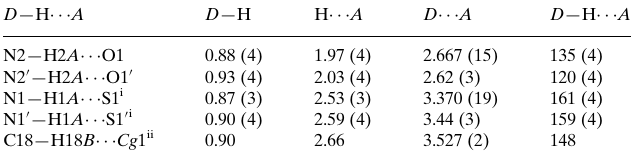
Hydrogen-bond geometry (A ˚ , (cid:2) ). Cg 1 is the centroid of the C1–C5/C10